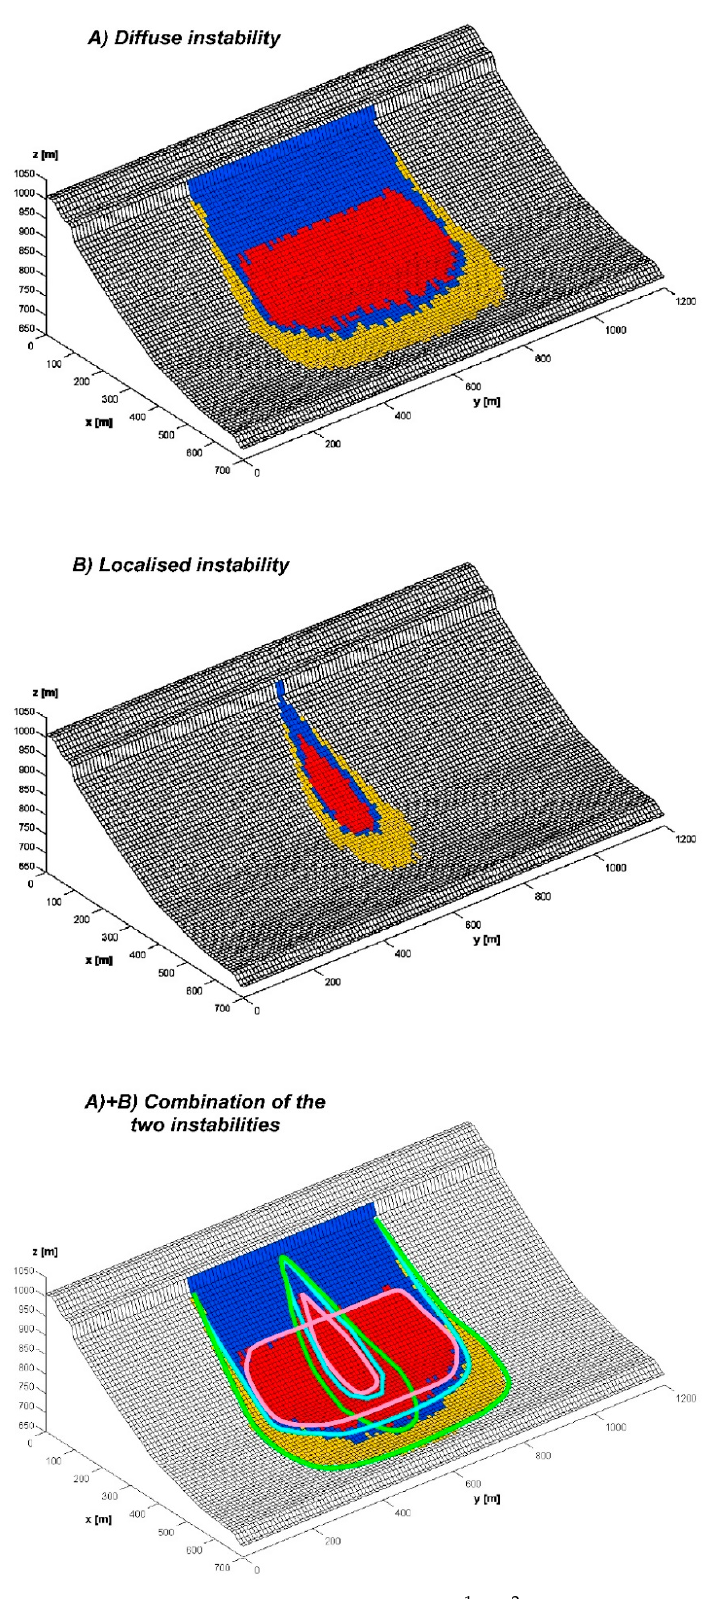
Figure 10. Combination of a diffuse ( λ f, 2 D = 0.002 (years − 1 ·m − 2 ), i.e., λ f,cell = 0.2 years − 1 ) and a localised instability ( λ f, 2 D = 0.02 (years − 1 ·m − 2 ), i.e., λ f,cell = 2 years − 1 ) for a linear cliff slope geometry. The boundaries of each of the two separate hazard zoning maps ( A ) and ( B ) are superimposed to the map obtained from their combination, ( A ) + ( B ).